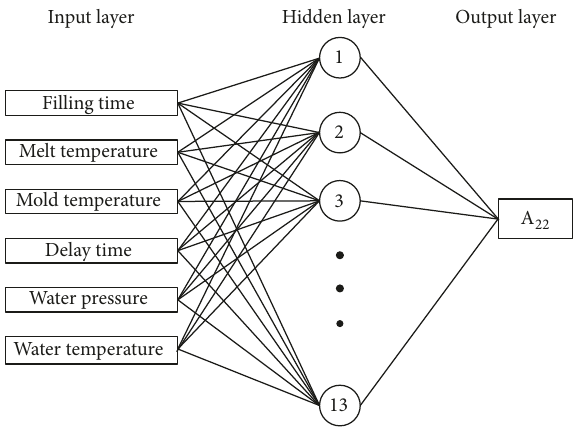
Figure 4: Topology of artificial neural